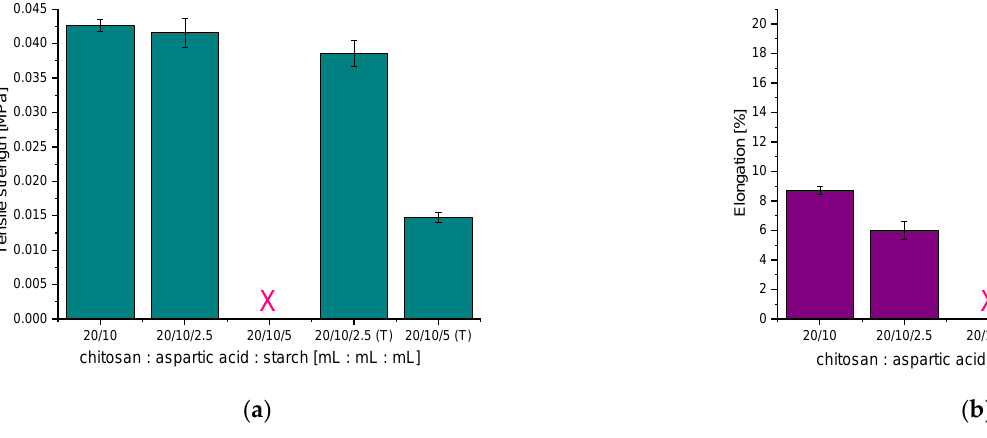
Figure 11. Tensile strength ( a ) and elongation ( b ) of hydrogels modified with starch. Performed mechanical studies allowed to state that the materials modified with